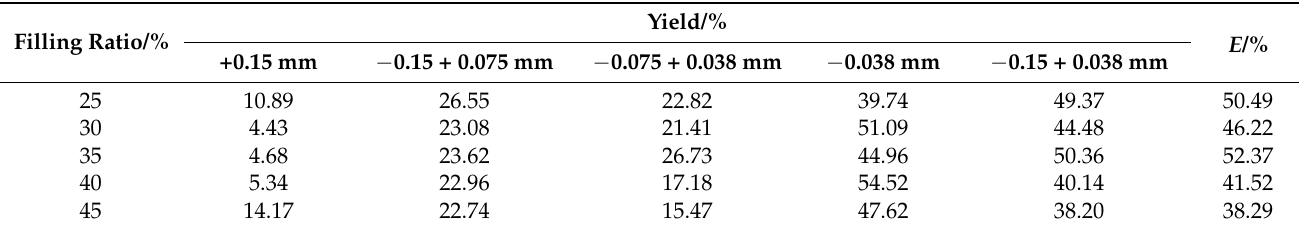
Table 10. Particle size composition of grinding product at different filling